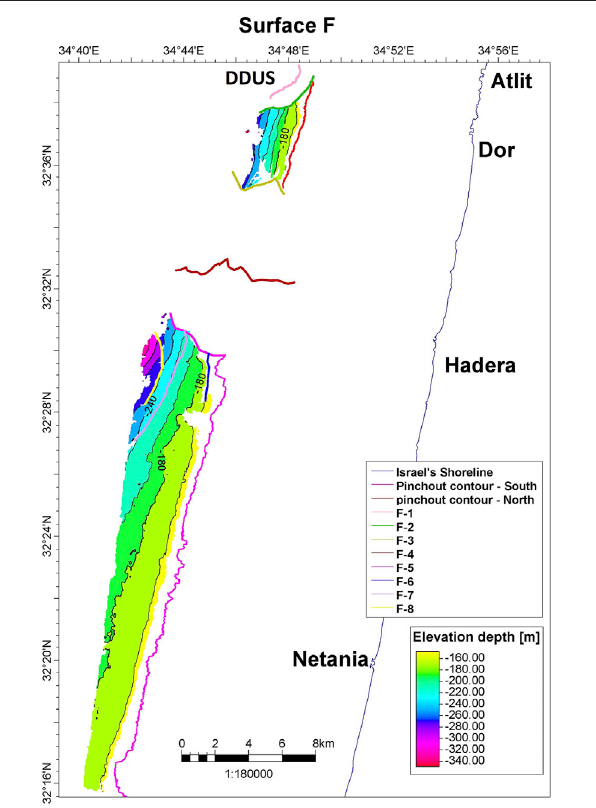
FIGURE 9 | Seismic mapping of Horizon E.